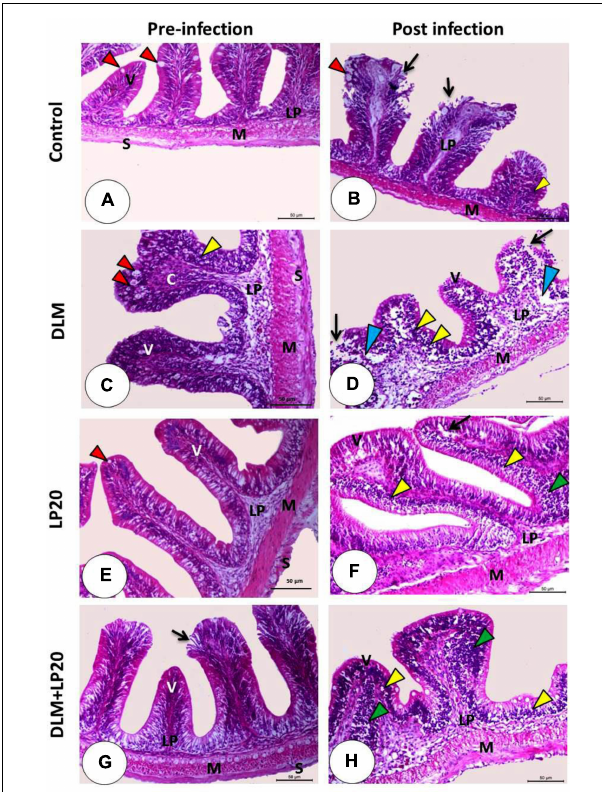
FIGURE 7 | Histomicrograph of the intestine of Nile tilapia subjected to four treatments (control, DLM, LP20, and DLM + LP20) before infection (A,C,E,G) and after (B,D,F,H) infection. Panel (A) shows normal histological structures including the intestinal villi (V) lined by enterocytes with goblet cells (red arrowhead), lamina propria submucosa (LP), tunica muscularis (M), and tunica serosa (S), while the post-infected group (B) shows degeneration and necrosis of the apical half of the villi with desquamated enterocytes (black arrow) with lymphoepithelium (yellow arrowhead). The toxic effect of DLM (C) causes congestion of the apical part of the villi with increased goblet cells (red arrowhead) and lymphoepithelium (yellow arrowhead), while the post-infected group (D) shows severe edema (blue arrowhead), degeneration and desquamation of enterocytes (black arrow), and lymphoepithelium (yellow arrowhead). The LP20 group shows increased length of the villi, while the post-infected group (F) shows intact villi with pyknotic nuclei of the apical enterocyte (black arrow) with lymphoepithelium (yellow arrowhead) and immune cell infiltration (green arrowhead). In panel (G) , the intestinal villi are intact and appeared normal except some degeneration and desquamation in the apical region of the villi (black arrow), while the post-infected group (H) shows stunted growth with lymphoepithelium (yellow arrowhead) and mononuclear cells (green arrowhead). Stain H&E. Bar = 100 µ m.